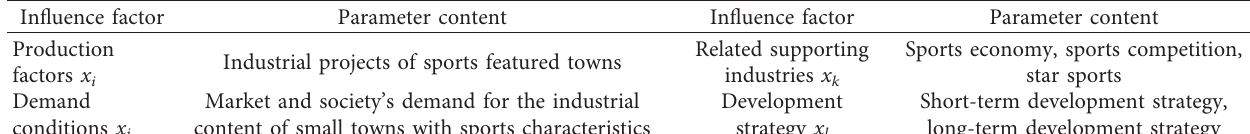
Table 1: Influencing factors of sports characteristic town competitiveness.